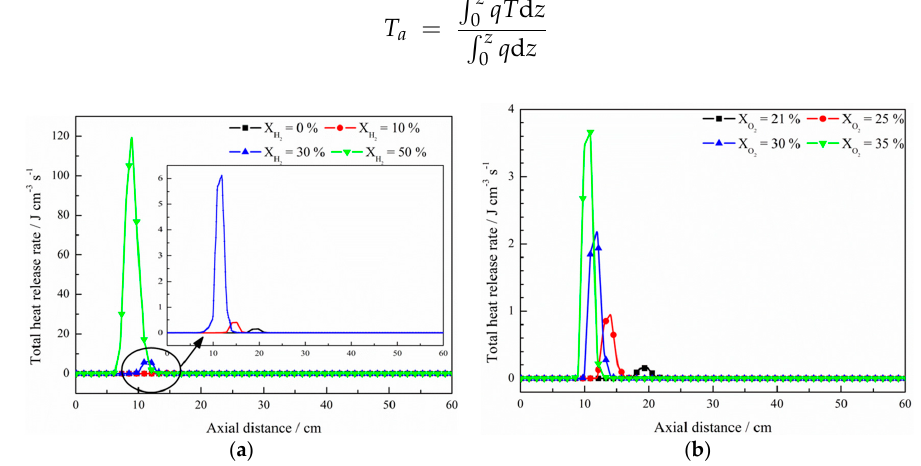
Figure 7. Heat release rate of biogas flames under H 2 -enriched ( a ) and O 2 -enriched ( b ) conditions along the centerline.